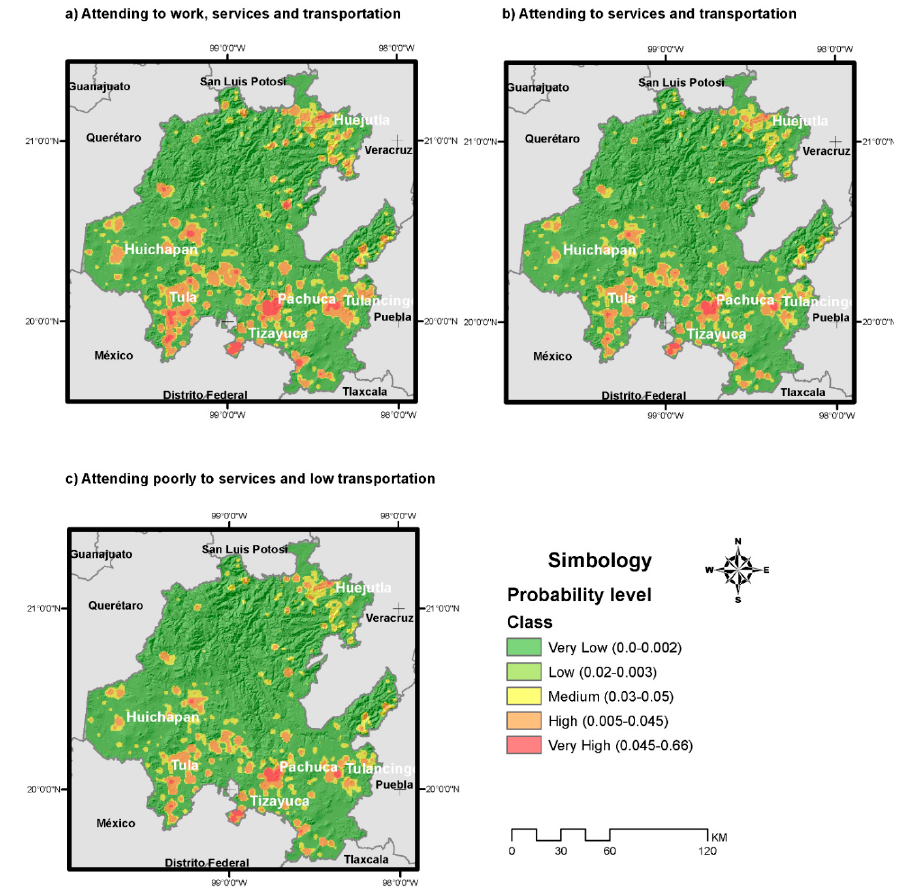
Figure 4. Probability of infection weighted by population density, considering ( a ) no restrictions in mobility, ( b ) 30% restrictions in mobility to services, and ( c ) more than 30% restrictions in mobility.